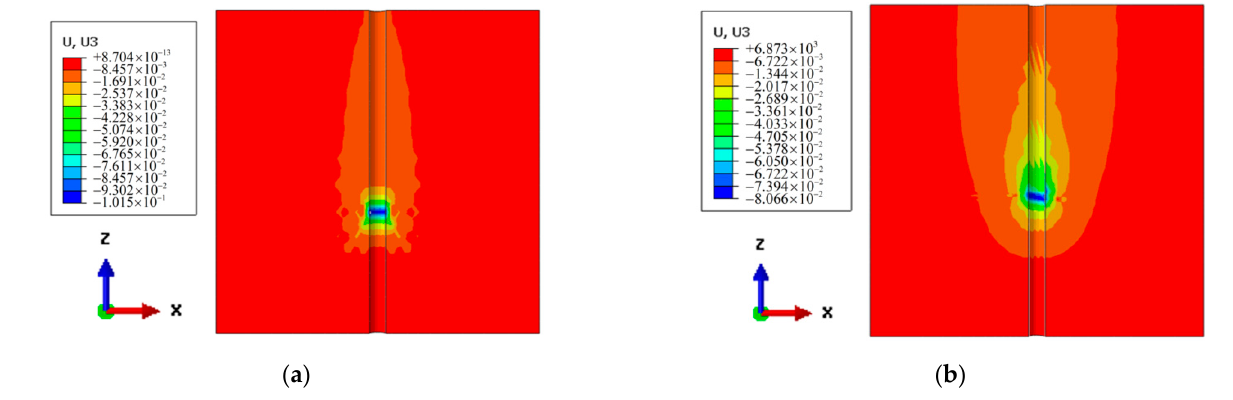
is 0.39 m, and that of the spiral pile is 0.055 m. The deformation of the helical pile is much smaller than that of the monopile. Displacements of the helical pile and monopile are largest at the bottom of the pile and develop into the surrounding soil. Due to the anchoring effect of the spiral blade, the soil around the pile bears more load and provides a certain bearing effect. The influence of displacement of the helical pile side soil is much larger compared with the monopile.